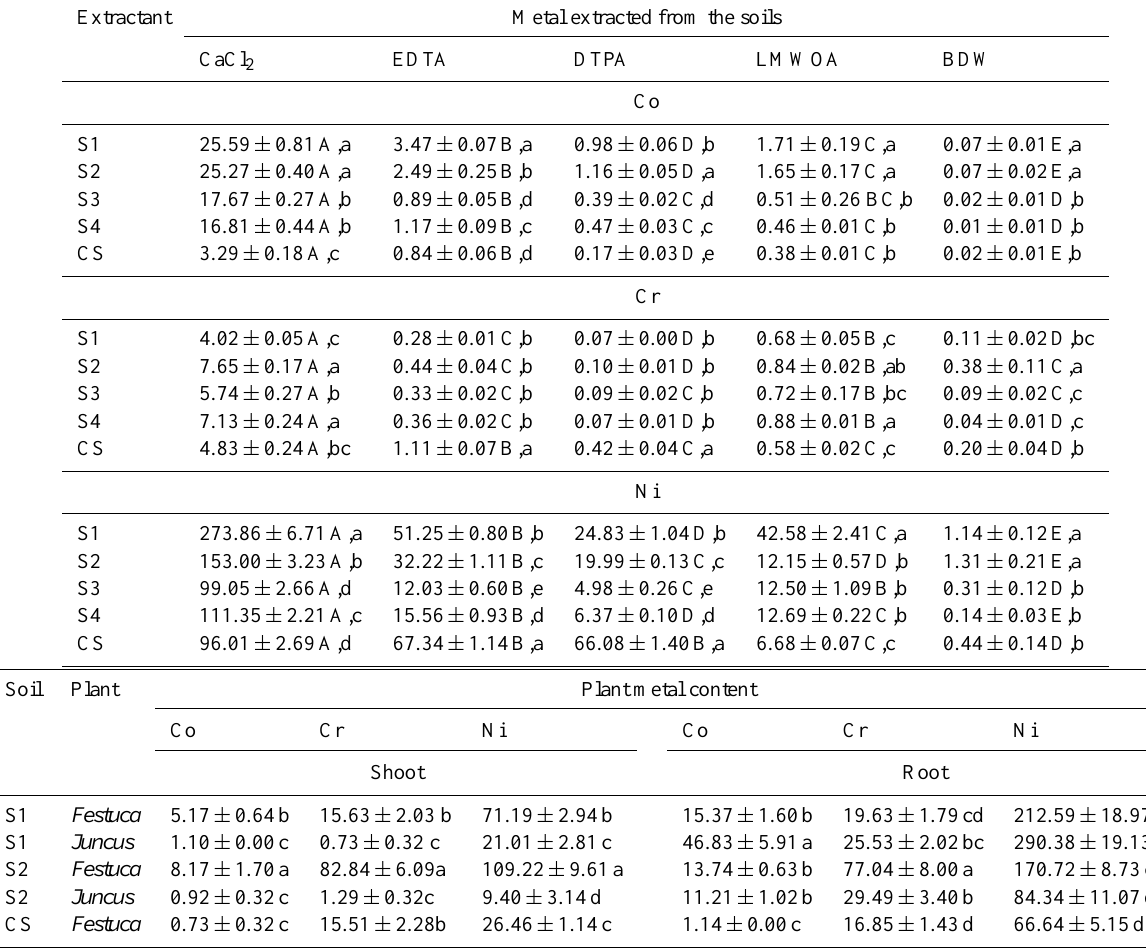
Table 4. Mean values and standard deviation of metal extracted from soils, and content in plants (mgkg − 1 ). Extractant Metal extracted from the